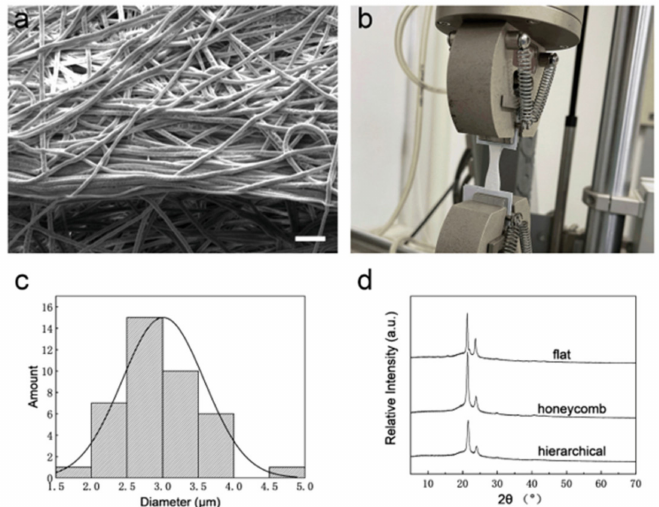
Figure 6. Characterization of the hierarchical self-assembled film (obtained at a receiving plate temperature of − 10 ◦ C, an ambient humidity of 70% and a fiber receiving distance of 8.5 cm). ( a ) SEM image of hierarchical structures self-assembled by uniform porous fibers when the collecting distance is 8.5 cm. The scale bar is 20 µ m. ( b ) Mechanical test. ( c ) Fiber diameter distribution. ( d ) XRD patterns of flat film, honeycomb film (which has a self-assembled structure, but smooth fiber surface) and hierarchical film (which has a self-assembled structure and micropores on the fiber surface) (the flat film sample was obtained with a receiving temperature of 23 ◦ C, an ambient humidity of 50% and a fiber acceptance distance of 15 cm. The honeycomb film sample was obtained with a receiving temperature of − 10 ◦ C, an ambient humidity of 50% and a fiber acceptance distance of 15 cm. The hierarchical film sample was obtained with a receiving temperature of − 10 ◦ C, an ambient humidity of 70% and a fiber acceptance distance of 8.5 cm). Table 1. Anisotropy of hierarchical film with uneven morphology (obtained with a receiving